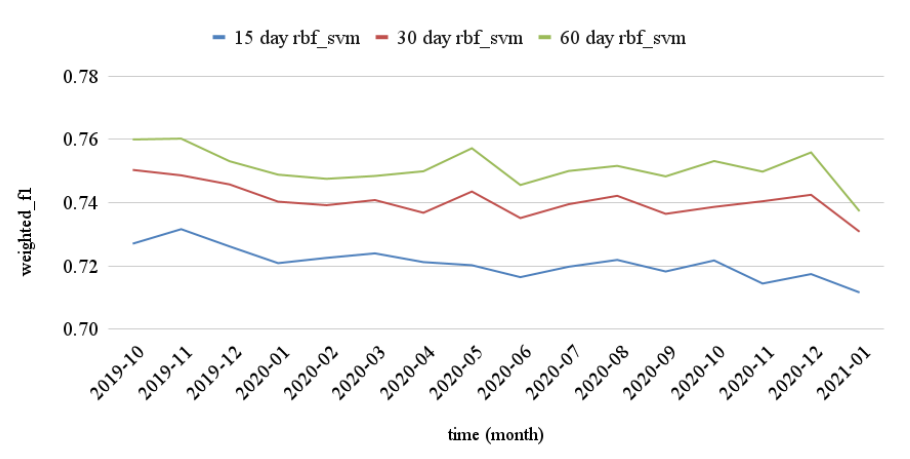
Figure 5. Comparison of best models for each scenario (initial training window of 15, 30, and 60 days), averaged by month, using features extracted from Google pretrained